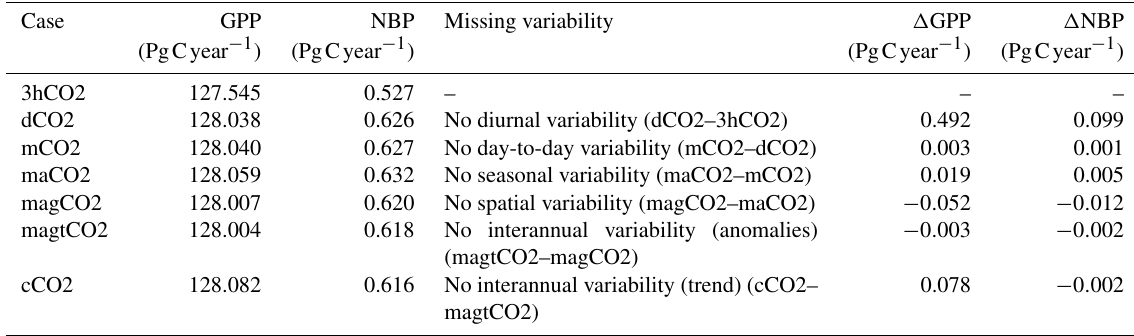
Table 1. Changes in mean global GPP and NBP for 2001–2014, resulting from a series of simulations representing the removal of temporal and spatial variability in atmospheric CO 2 concentrations. Delta ( (cid:49) ) indicates the difference due to removal of spatial–temporal variability (see Fig. 1 for